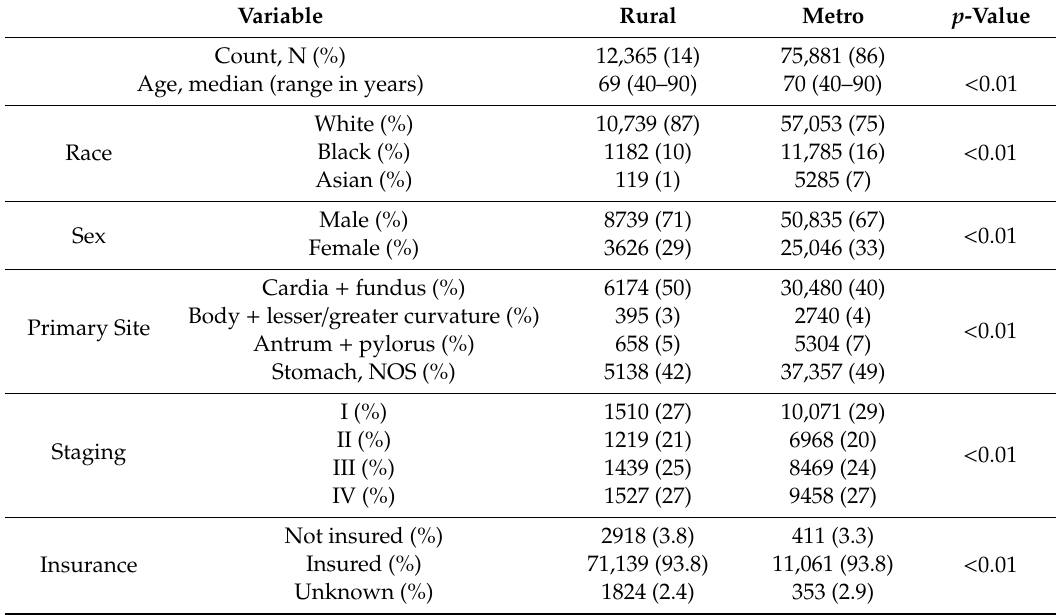
Table 1. Demographic and clinical characteristics of patients with gastric adenocarcinoma residing in rural and metro